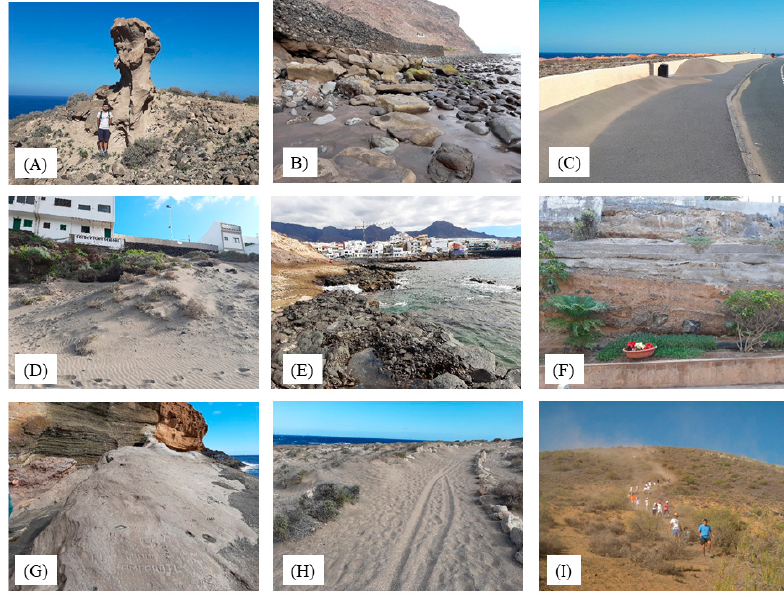
Figure 7. ( A ): Quarries in Milán; ( B ): farming in Igueste de San Andrés; ( C ): roads and walls in Montaña Pelada tuff ring; ( D ): local buildings in Punta de Abona; ( E ): tourism in la Caleta; ( F ): gardens in Los Gigantes. ( G ): graffiti in the palaeodune in Montaña Amarilla tuff ring. ( H ): paths in El Médano-Montaña Roja. ( I ): pilgrimage in Malpaís de Güímar. Source: authors.